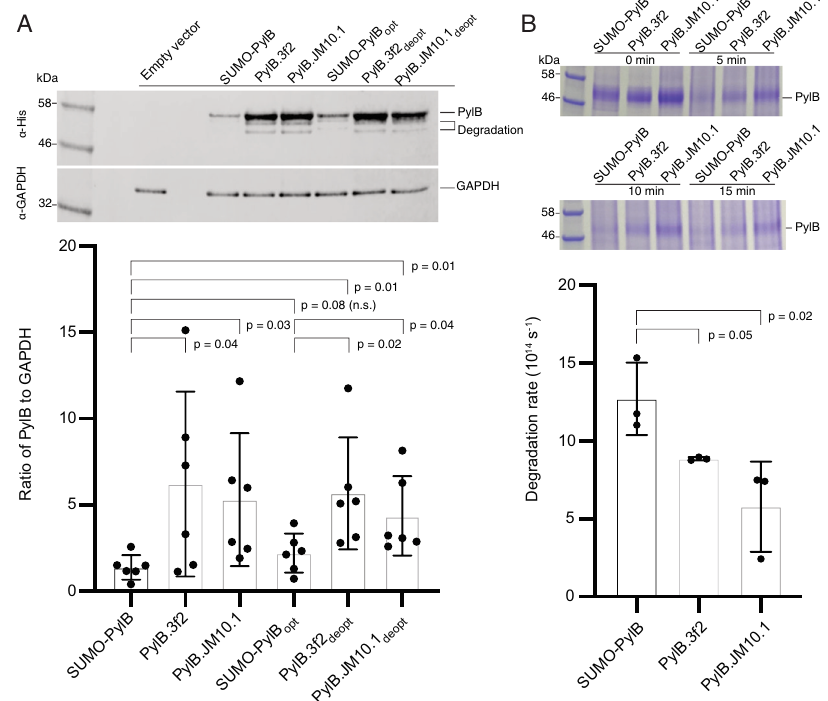
Fig. 4 Evolved PylB mutants are present at elevated levels inside cells, and show increased protease resistance. A Quantitative western blot assays were performed on clari fi ed lysates of cells expressing different His-tagged PylB variants. Prior to cell lysis, cultures all found to exhibit similar OD 600 values (3.1 – 3.3), colony-forming units (1 – 3 × 10 9 CFUs/mL), and cell pellet wet weights (1.2 – 1.4 g). For each sample, His-tag antibodies were used to quantify PylB, and samples were normalized using the housekeeping gene GAPDH (see “ Methods ” ). These experiments show two evolved mutants, PylB.3f2 and PylB.JM10.1, are present at a higher concentration compared to the ancestral variant SUMO-PylB. These results further show that two codon- deoptimized evolved mutants, PylB.3f2 deopt and PylB.JM10.1 deopt , are also present at higher concentrations compared to the codon-optimized ancestral variant SUMO-PylB, suggesting that the elevated levels of evolved mutant proteins likely do not results from improved codon usage. B Proteolytic degradation assays were performed using puri fi ed PylB variants. Protein samples were incubated with the protease enzyme chymotrypsin, and the concentration of PylB was evaluated over time (see “ Methods ” ). Evolved mutants PylB.3f2 and PylB.JM10.1 were found to degrade at a slower rate compared to the ancestral variant SUMO-PylB, indicating increased protease resistance in the evolved mutants. Samples were tested in biological sextuplicate; data shown represent mean values± s.d. For both fi gures A and B , p values were calculated using a one-tailed Student ’ s t -test, without adjustments for multiple comparisons. Source data are provided as a Source Data fi